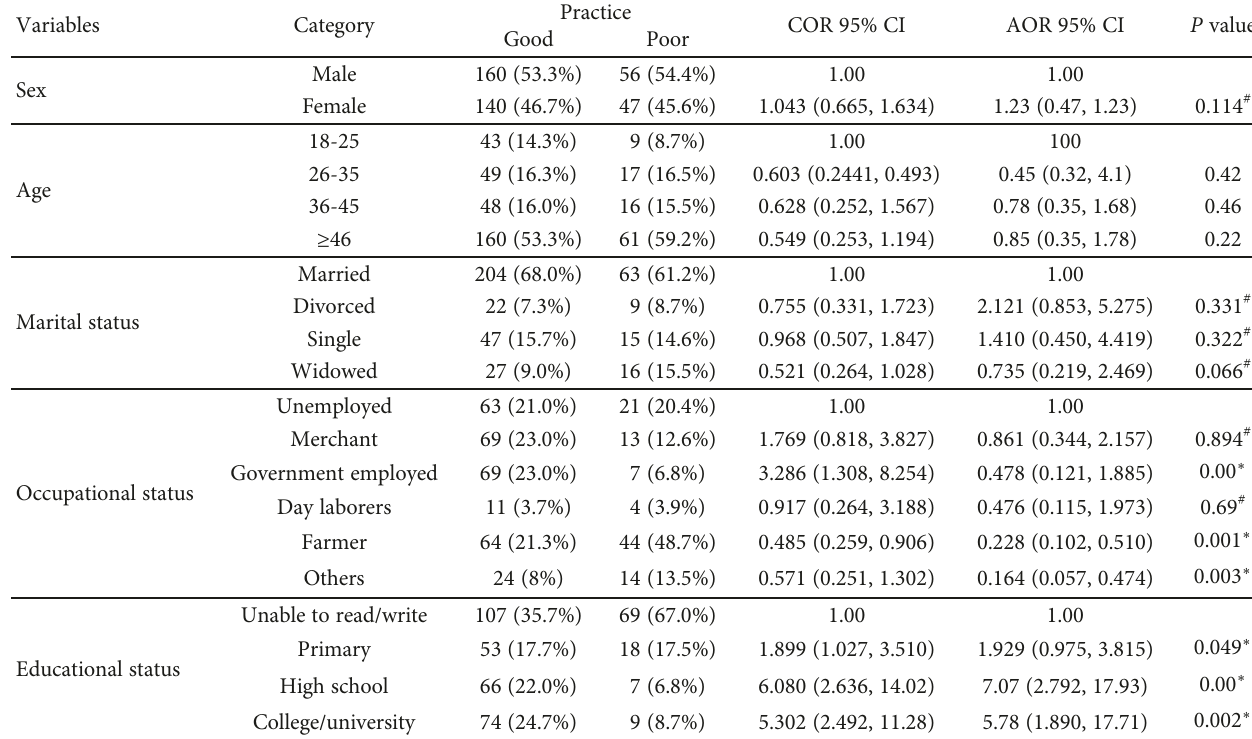
Table 7: Bivariable and multivariable analysis of factors associated with practices towards glycemic controls on DM patients at the University referral hospital of Gondar, 2018.